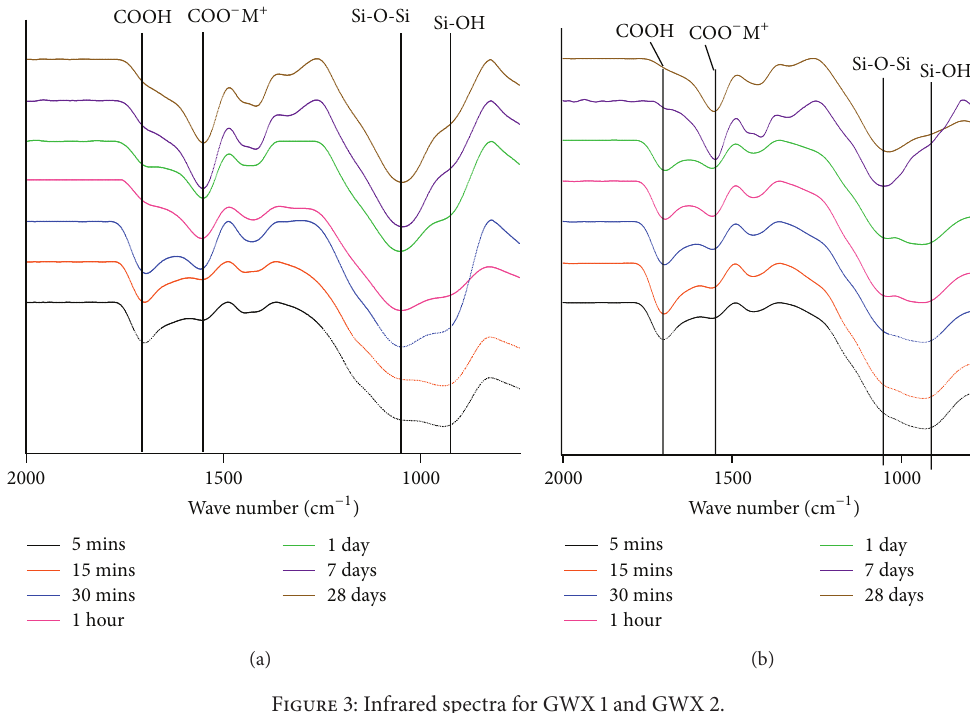
Figure 3: Infrared spectra for GWX 1 and GWX 2.